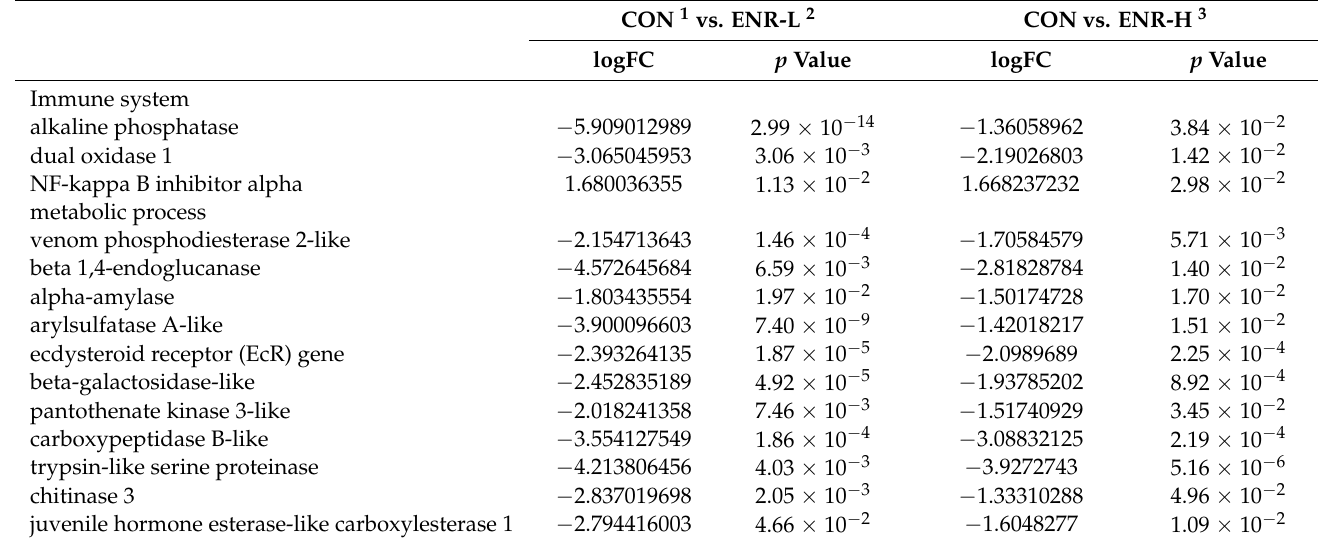
Table 2. Summary of DEGs related to immune system and metabolic processes in the E. sinensis transcriptome.